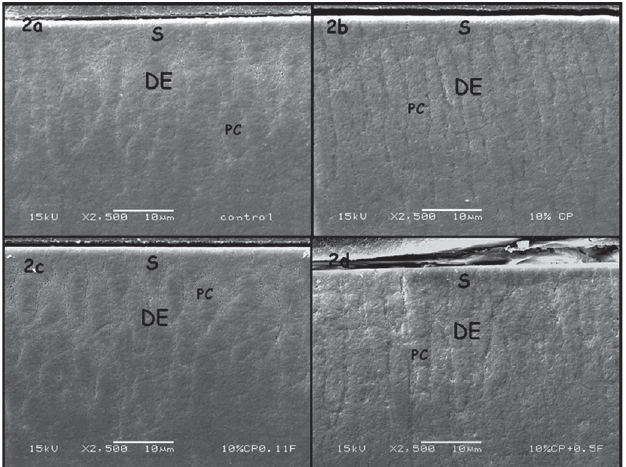
Fig. 2. Scanning electron microscopy micrographs of sub-superficial enamel (×2,500): specimens subjected to artificial saliva (2a); 10% carbamide peroxide (2b); 10% carbamide peroxide + 0.11% fluoride (2c) and 10% carbamide peroxide + 0.5% fluoride (2d). Figures 2a to 2d show enamel sub-superficial demineralization (DE) and the interprismatic matrix partially removed, exhibiting the prism cores (PC) (S – superficial enamel).